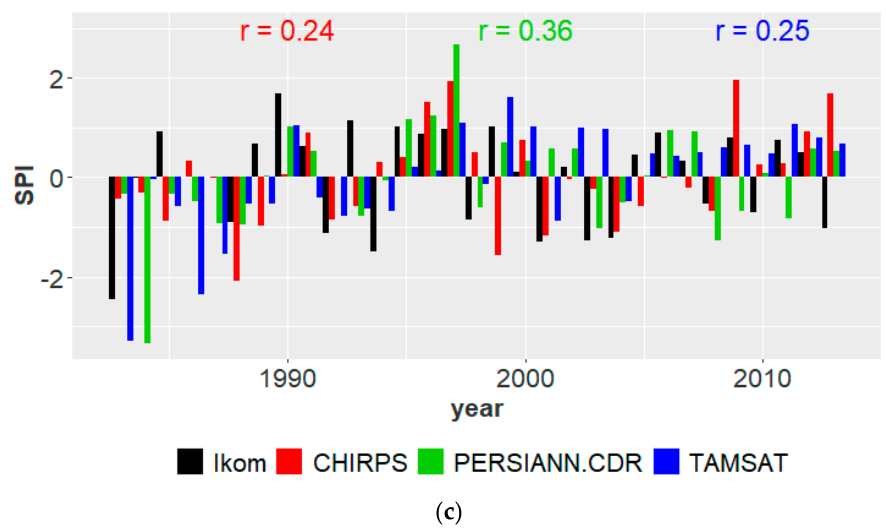
Figure 4. Inter-annual variations of standardized precipitation index (SPI) at ( a ) Kastina, ( b ) Bida, and ( c ) Ikom, located in the Sahel, Savannah and Guinea Coast climatic zones, respectively. Table 4. Correlation of Annual Rainfall Anomalies for Satellite Products with Respect to Gauge Data.